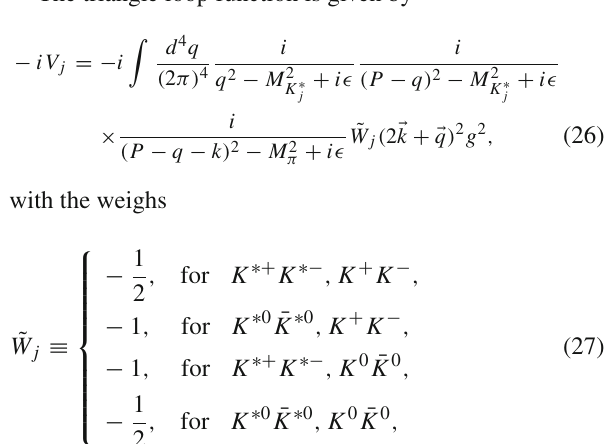
The triangle loop function is given